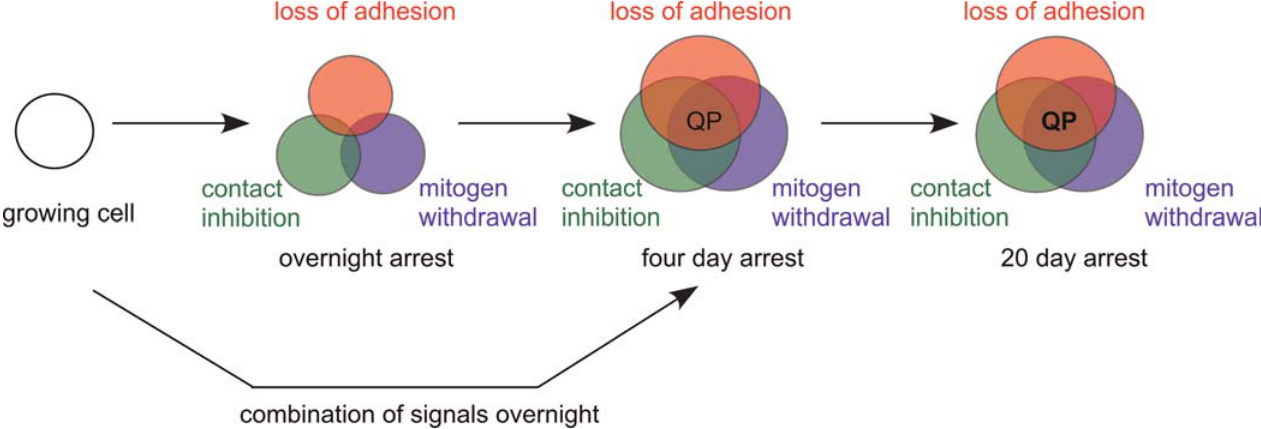
Figure 4. Summary of the Relationships among Quiescent States In cells arrested overnight by a specific arrest signal, gene expression changes are largely signal-specific with a small amount of overlap. When cells have been arrested for 4 d, there continue to be signal-specific changes, but now there are a large number of commonly regulated genes that we refer to as a ‘‘ quiescence program. ’’ In cells arrested for 20 d, the intensity of the changes in the quiescence program are magnified. The three circles are intended to reflect the enhancement of the quiescence program at 20 d. We have not analyzed all the three arrest conditions at this late time point. When cells are arrested by a combination of extracellular signals, quiescence program gene expression changes appear after only an overnight arrest. DOI: